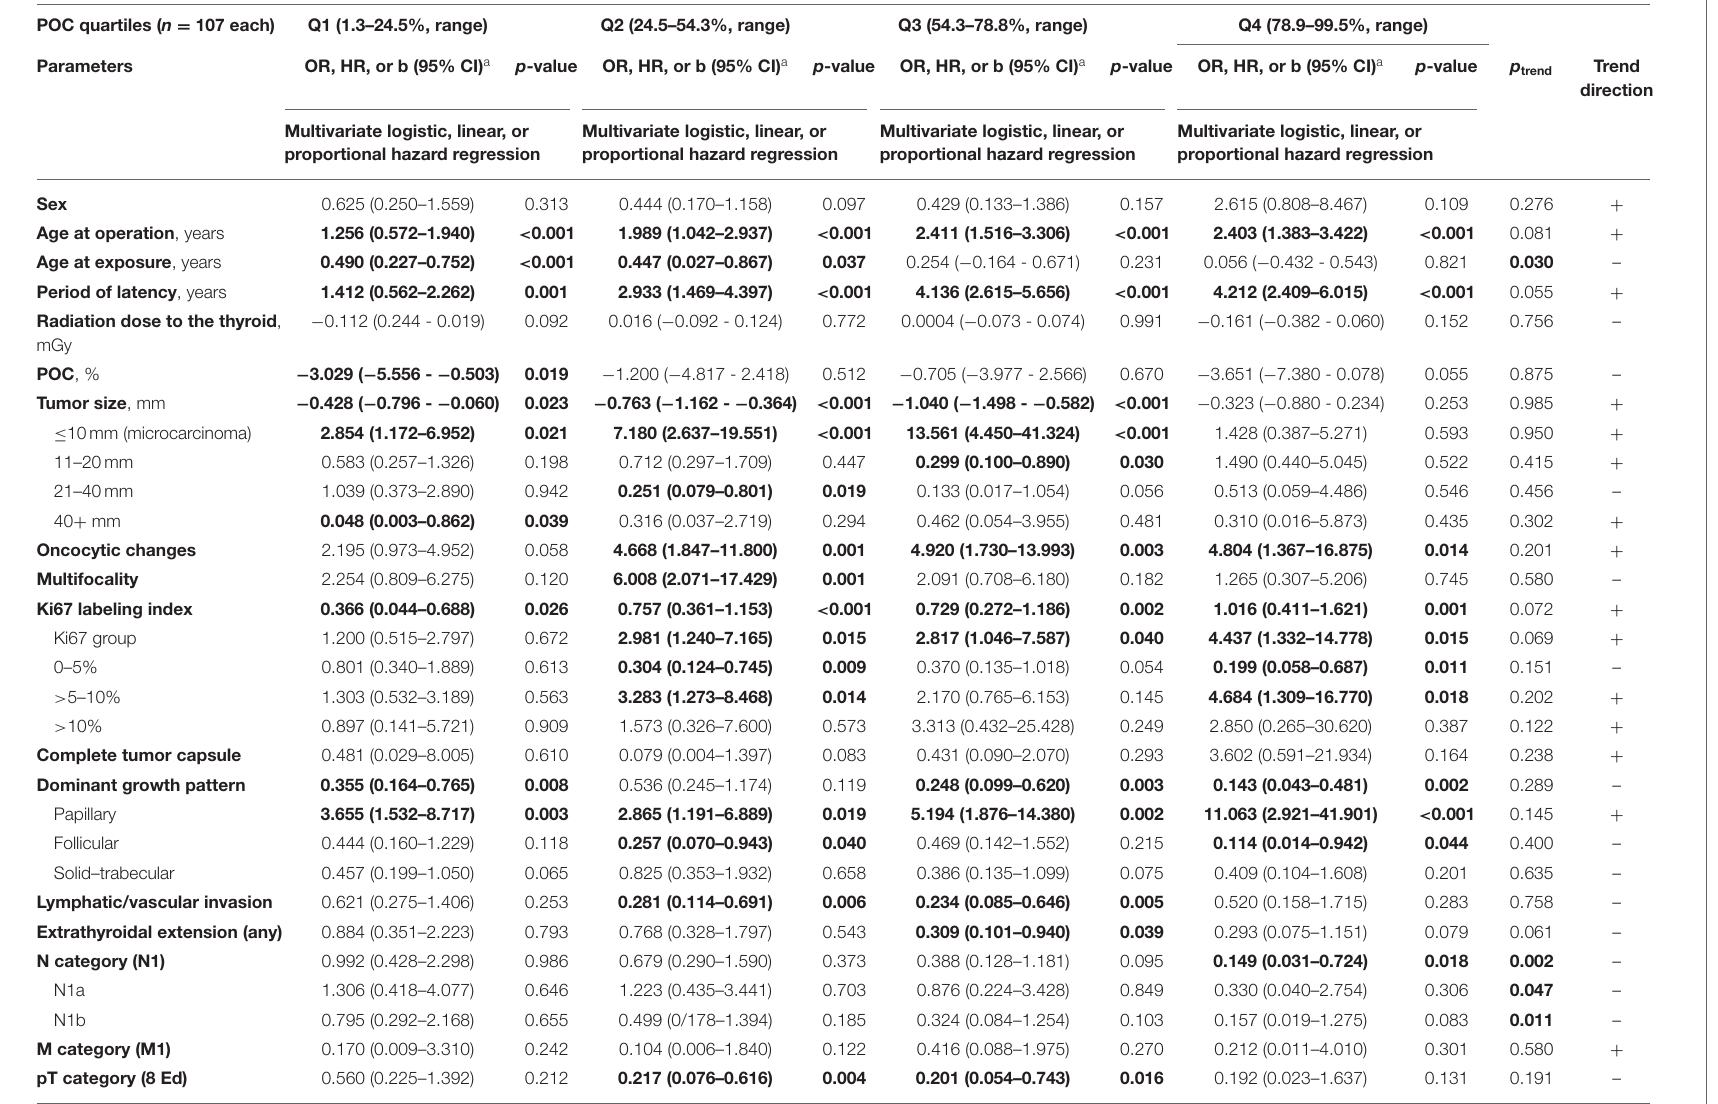
TABLE 3 | Comparison of the BRAF V600E -positive vs. BRAF V600E -negative PTCs by POC quartiles. POC quartiles ( n = 107